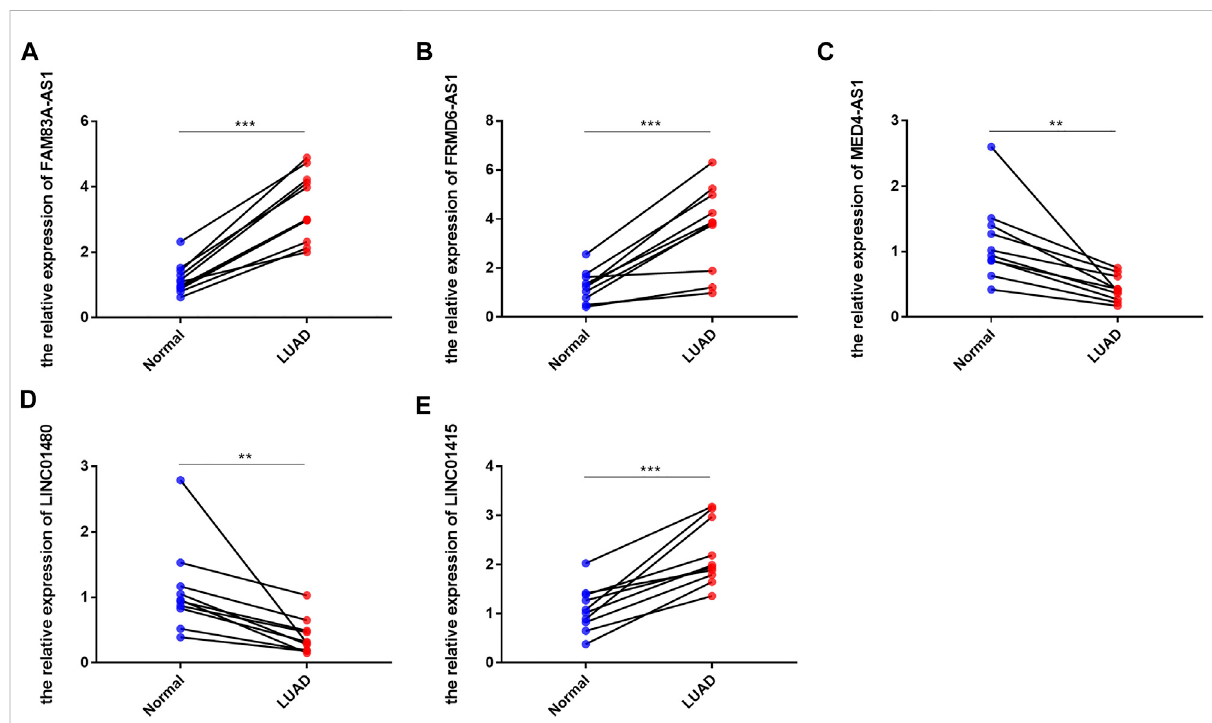
FIGURE 12 The expression level of six NRlncRNAs in lung adenocarcinoma tissues and adjacent normal lung tissues. Expression of FAM83A-AS1 (A) , FRMD6-AS1 (B) ,MED4-AS1 (C) ,LINC01480 (D) ,andLINC01415 (E)